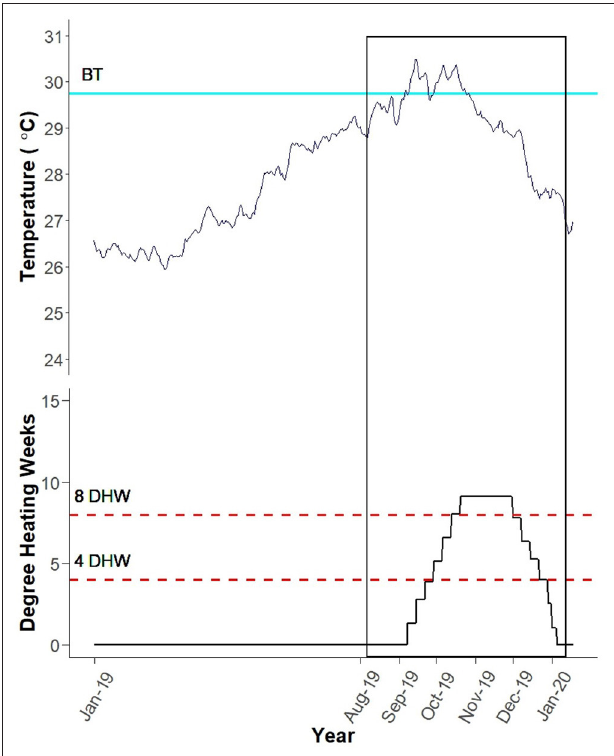
FIGURE 5 | Black Point Degree Heating Weeks (DHW). Blue line labeled “BT” depicts the site-specific bleaching threshold (Smith et al., 2016b). Black vertical box encompasses the monitoring period (August 13th, 2019–January 16th, 2020). Site-specific DHW were calculated using average daily temperatures recorded by HOBO temperature loggers at the reef level by TCRMP. Figure created by Rosmin